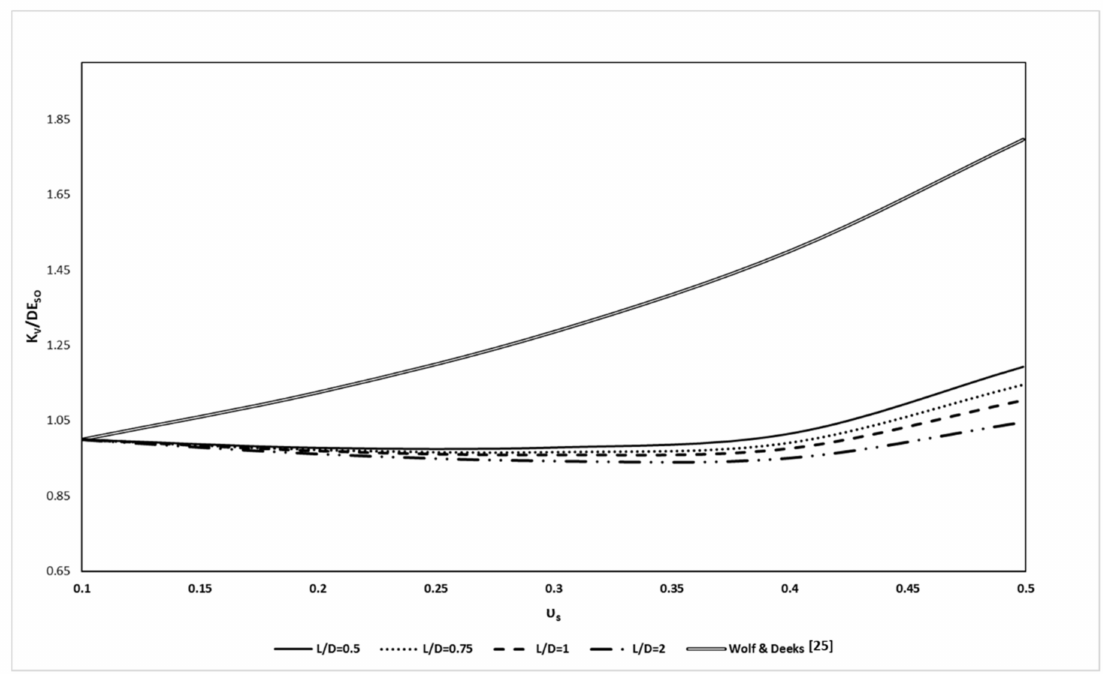
Figure 8. Variation of vertical stiffness (K v ) with Poisson’s ratio ( υ s ) and aspect ratio